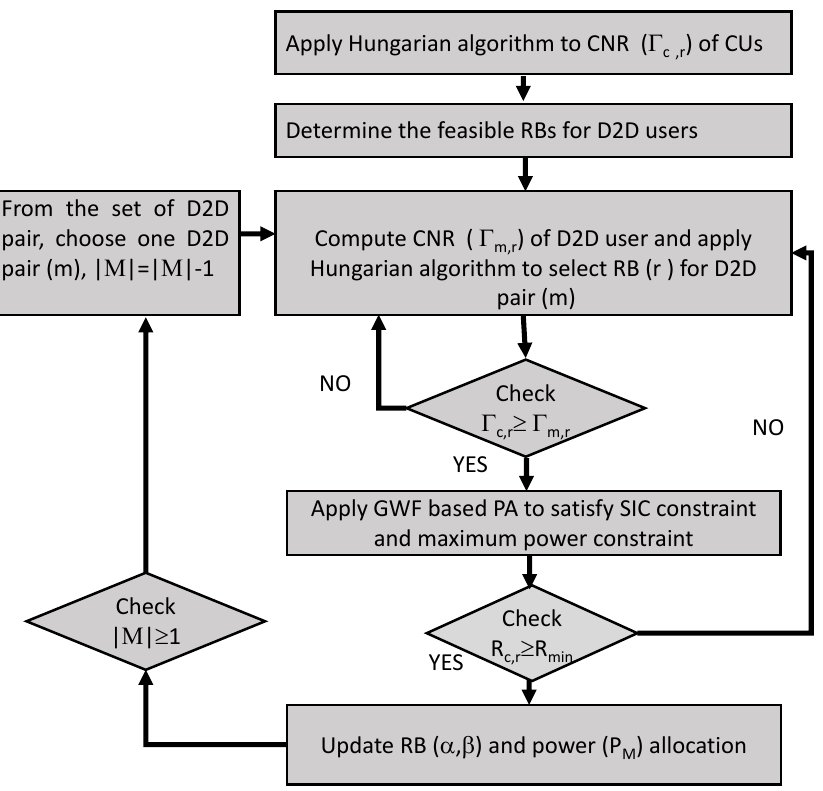
Figure 2. Iterative method for obtaining resource allocation { α , β , P M }